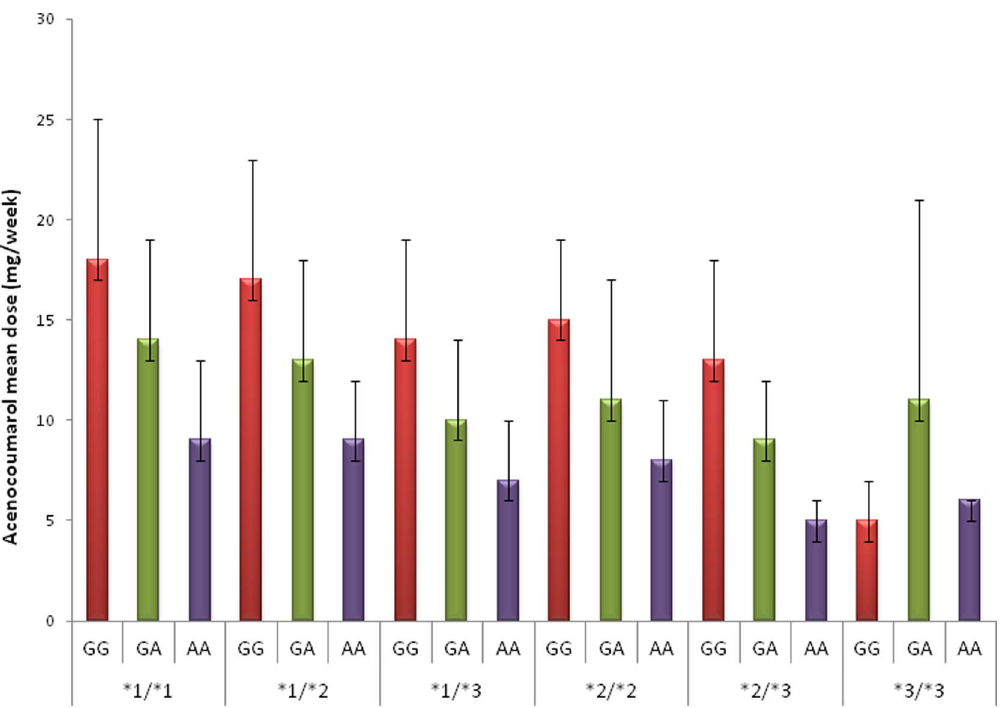
Figure 2. Ranking of acenocoumarol dose distribution in VKORC1 and CYP2C9 combined genetic profiles in 3949 anticoagulated patients.